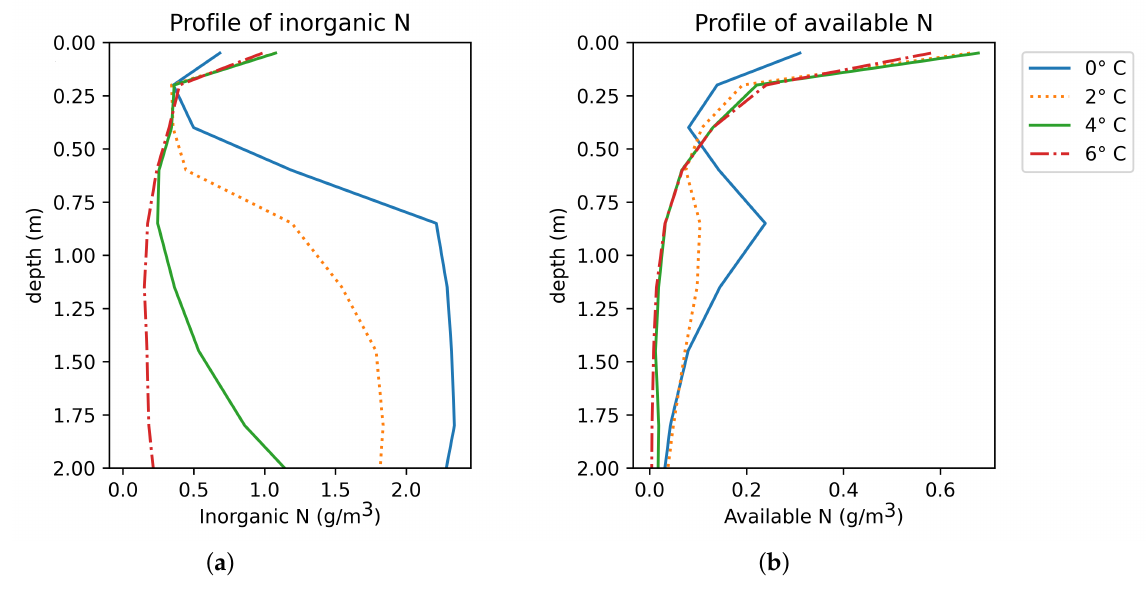
Figure 5. Profile of ( a ) total inorganic N and ( b ) plant available inorganic N along with its change over the future for the permafrost region using the CN spun configuration and the transient-ens for a range of GSAT changes in